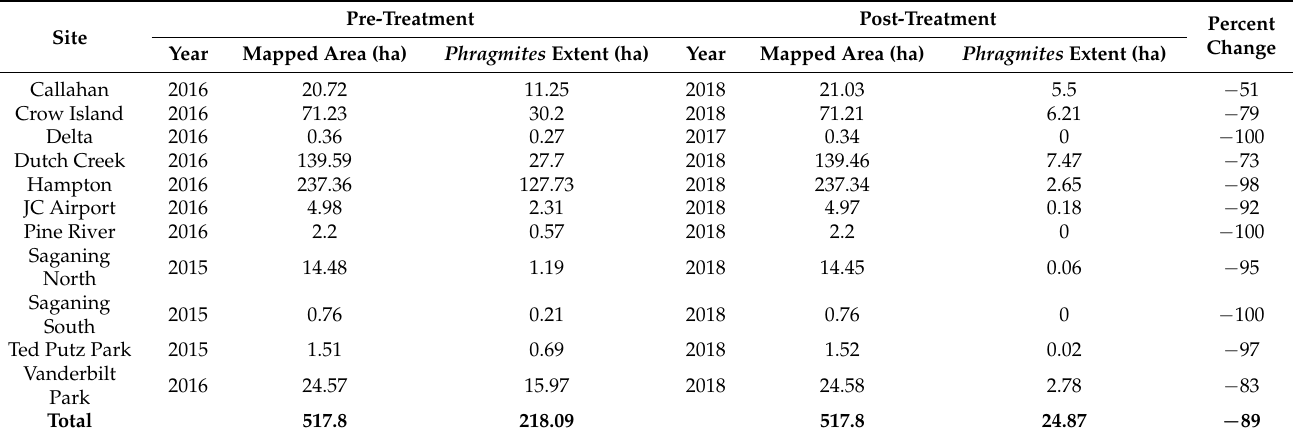
Table 4. Summary of pre- and post- treatment Phragmites extent as measured using high-resolution classification approach of